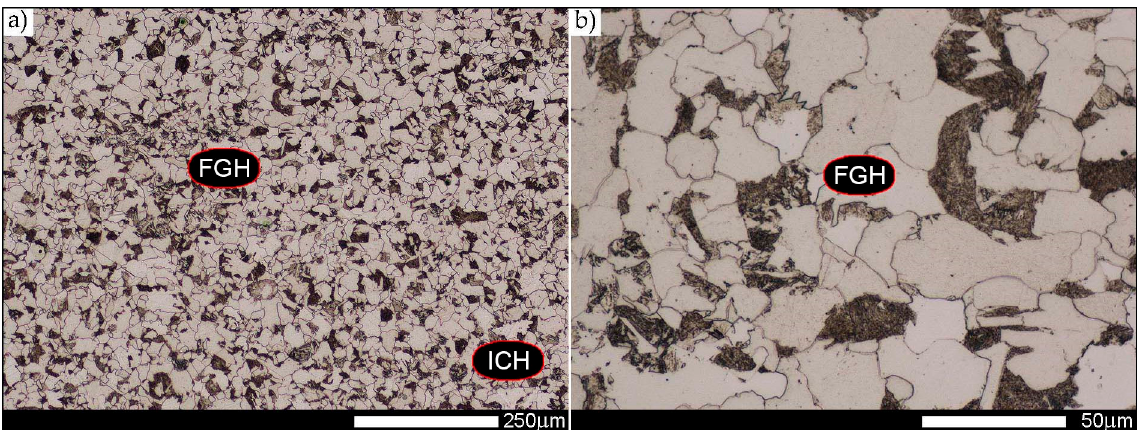
Figure 18. Welded joint microstructure of Hardox 450 steel in the normalised state—CGHAZ zone shown in Figure 2b. ( a ) 100 × ; ( b ) 500 × . Structure of near-equilibrium ferrite grains with pearlite colonies. Tertiary cementite is also observed, often forming a continuous network around the ferrite grains. FL—fusion line, CGH(AZ)—coarse-grained zone, FGH(AZ)—fine-grained zone. Light microscopy, etched with 3% HNO 3 .